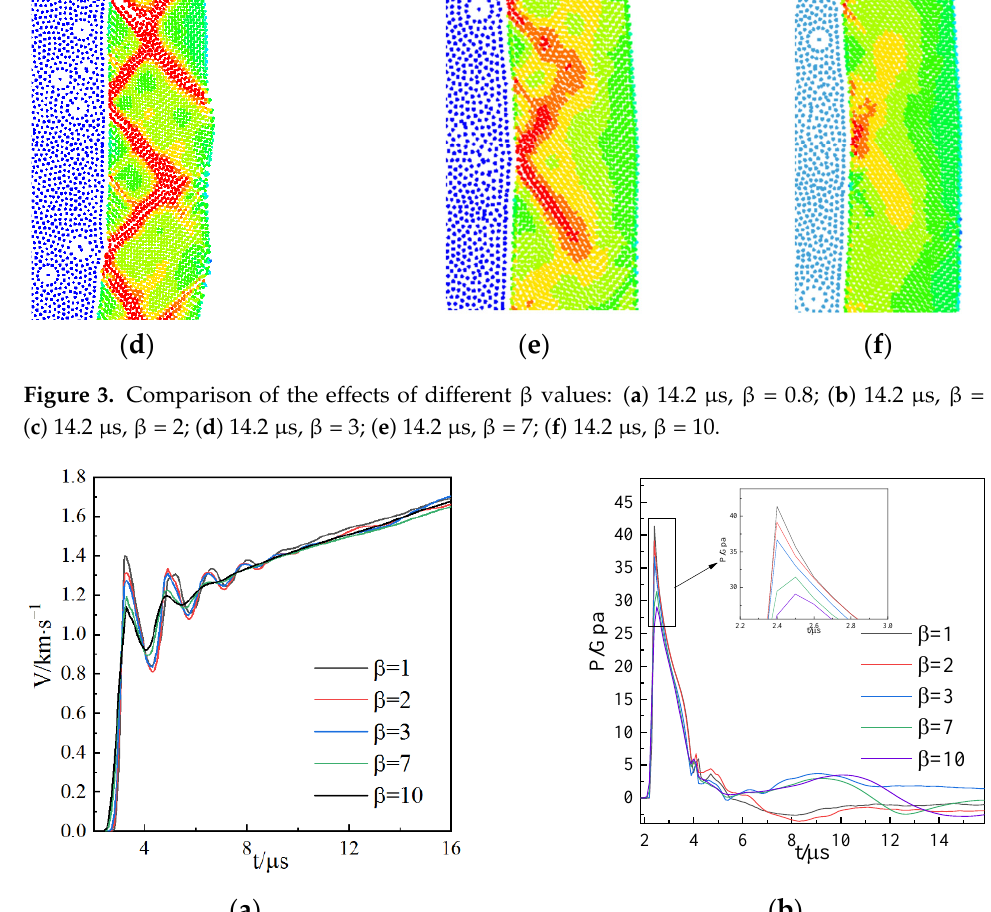
Figure 4. Comparison of data from different models: ( a ) velocity of the outer wall of the cylindrical shell and ( b ) internal hydrostatic pressure.